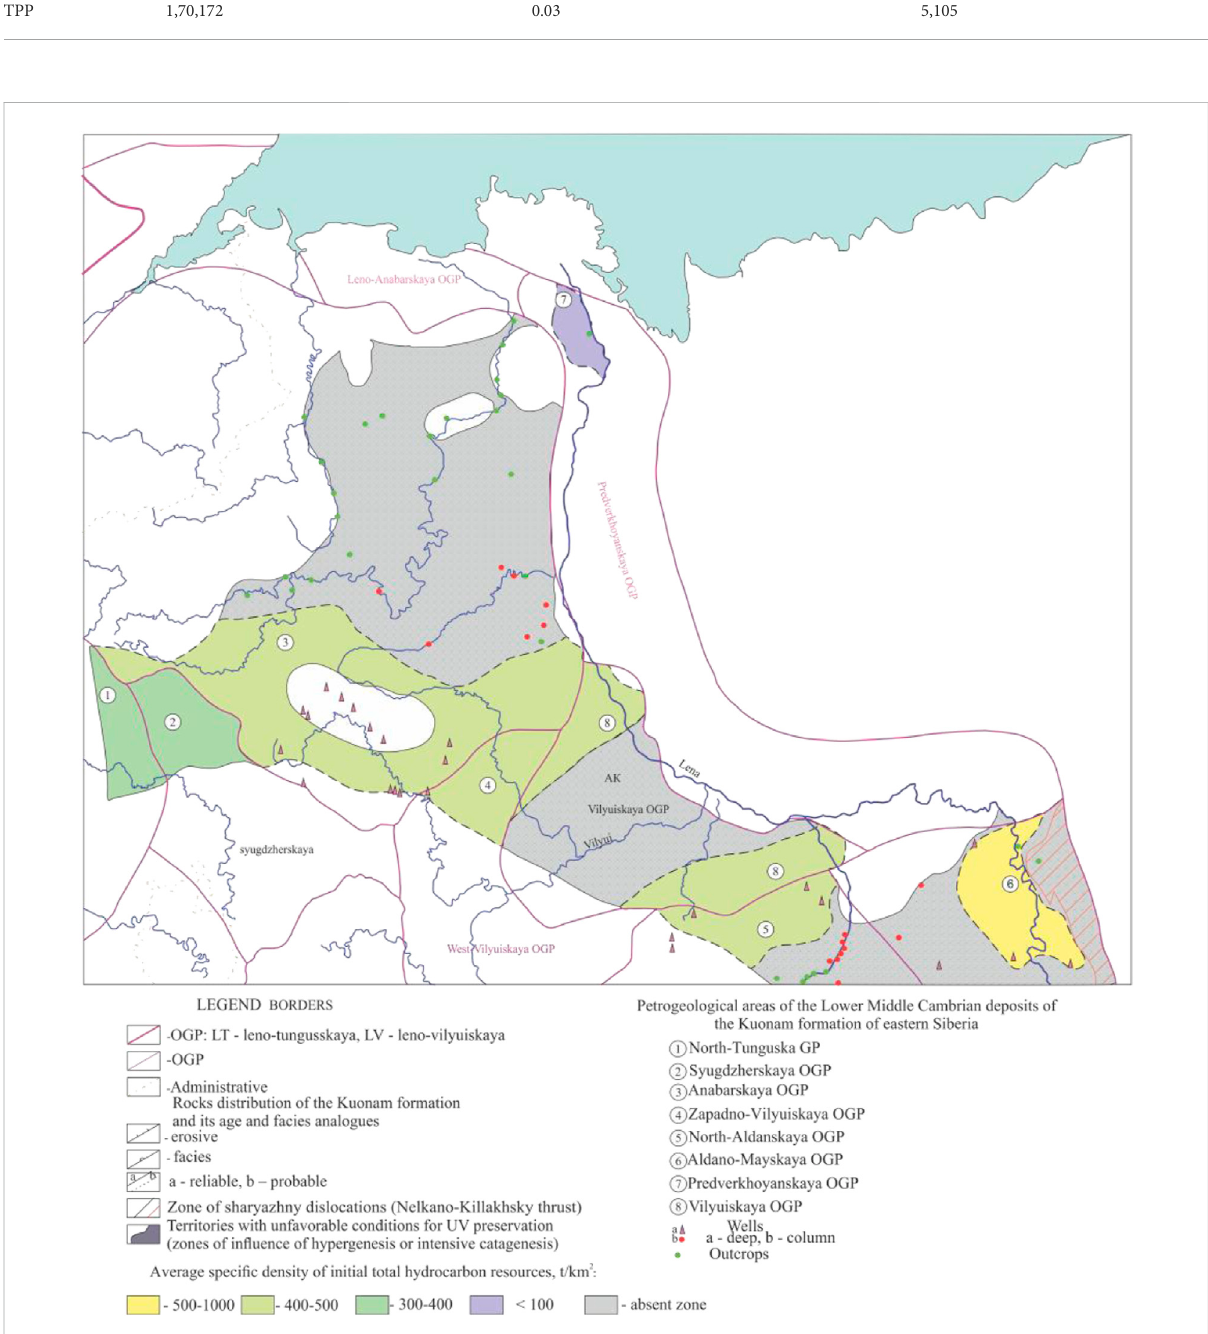
FIGURE 6 Distribution of the Kuonam formation within the Lena-Tunguska OGP (Smith, 1971).